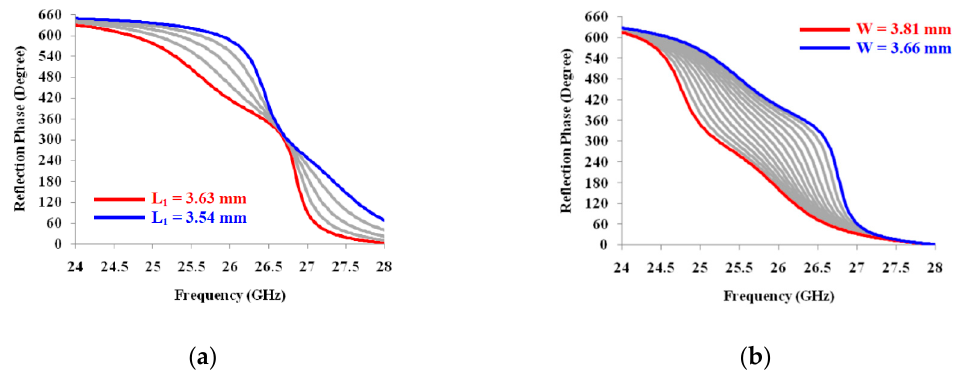
Table 1. Values in the second column of Table 1 belong to the optimization performed in Figure 3, and values in the third column of Table 1 are obtained by varying values of the second column when a ring slot is added in the ground plane.